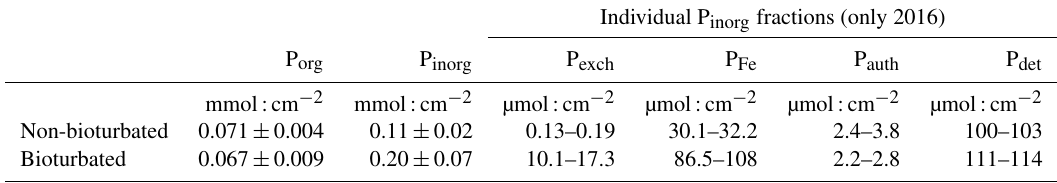
Table A5. Inventories of the individual phosphorus fractions. P org and P inorg are reported as mean ± 1SD; SEDEX fractions are given as a range (due to the low number of replicates) from the 2016 cores (the 2015 cores were omitted because some depth samples were not analysed for P